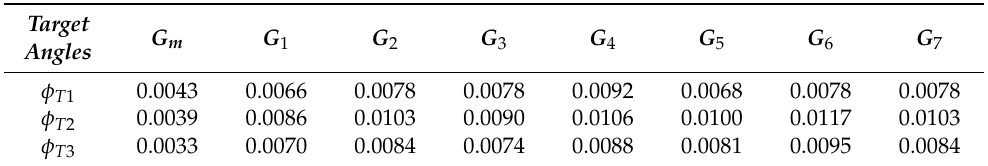
Table 4. MSE values of step responses for nominal plant functions G m and 7 plant functions ( G 1 to G 7 ).